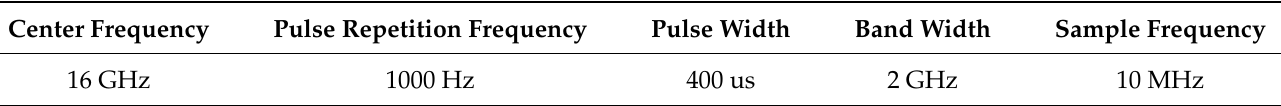
Table 1. Radar parameters of the simulation.